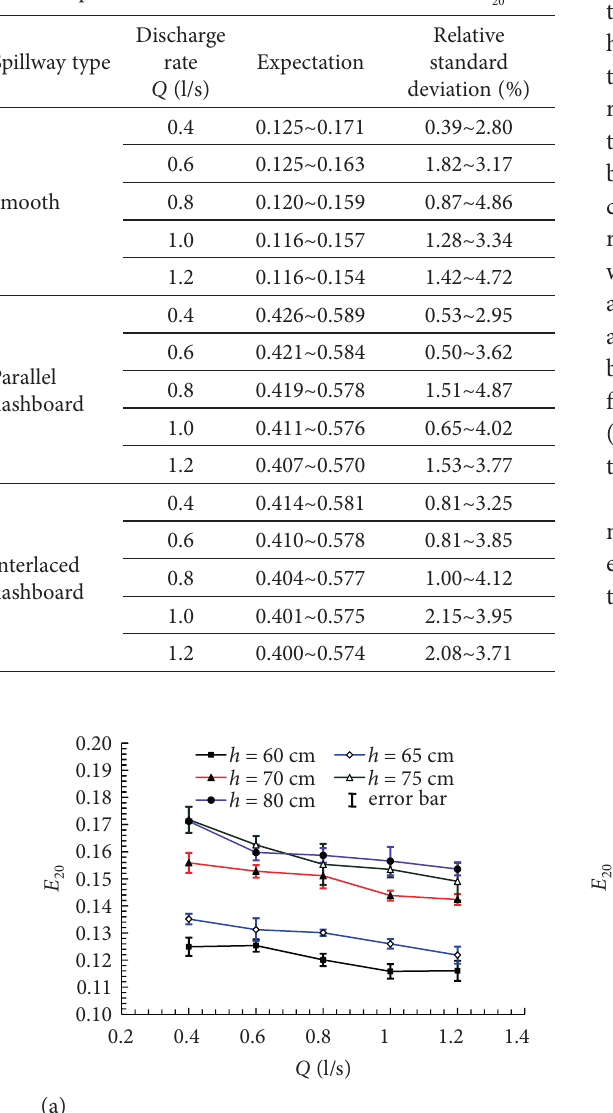
Table 2. Expectation and relative standard deviation of E